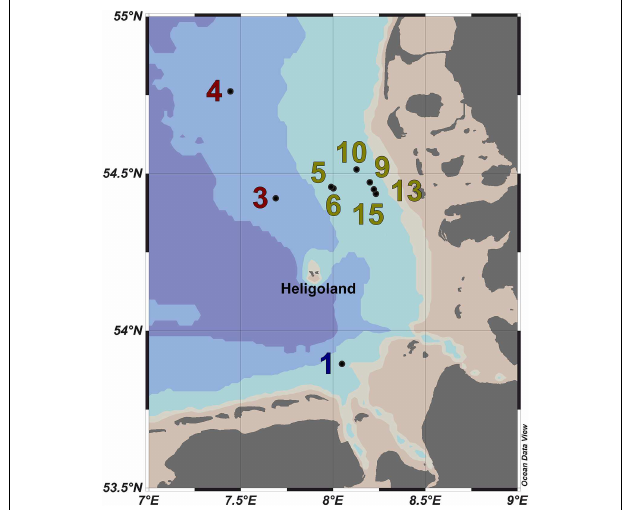
FIGURE 1 | Map of the German Bight showing the locations of the nine sampling stations visited in May 2010. Stations inside the examined phytoplankton bloom are depicted in green; those outside the bloom in red. Station 1 is depicted in blue as it was located in a bloom outside of the area of the examined bloom. Shading of the water masses refers to bottom depth. The map was generated using the Ocean Data View software package [version 4.7.2; Schlitzer, 2015